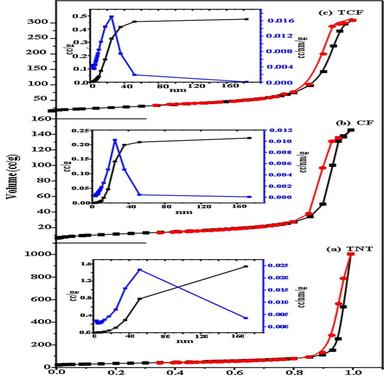
N2 adsorption-desorption isotherms and pore size/pore volume distribution curves (inset) of the prepared nanocomposite photocatalysts.